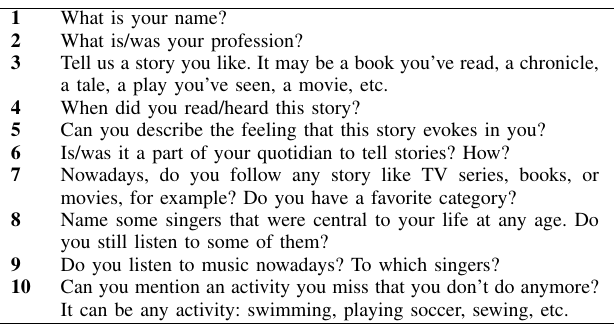
TABLE II Q UESTIONS ASKED DURING THE INTERVIEW